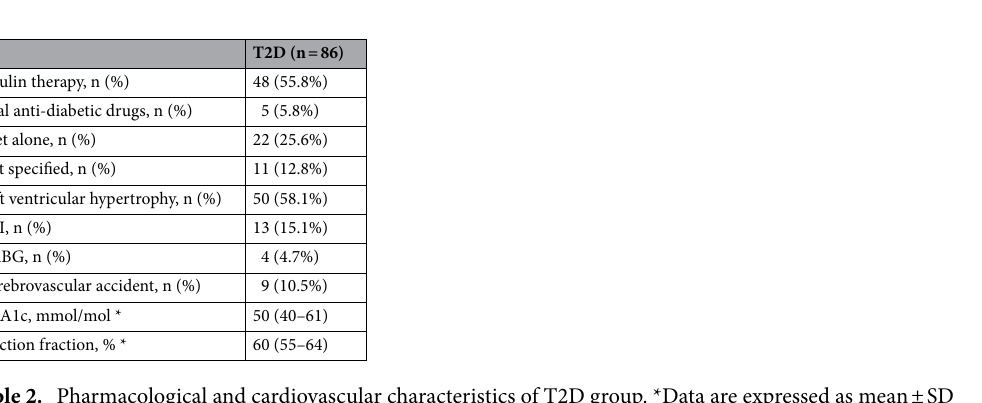
Table 2. Pharmacological and cardiovascular characteristics of T2D group. *Data are expressed as mean ± SD or median (25°–75° percentile) according to their distribution. PCI percutaneous coronary intervention, CABG coronary artery bypass grafting, HbA1c glycosylated haemoglobin.